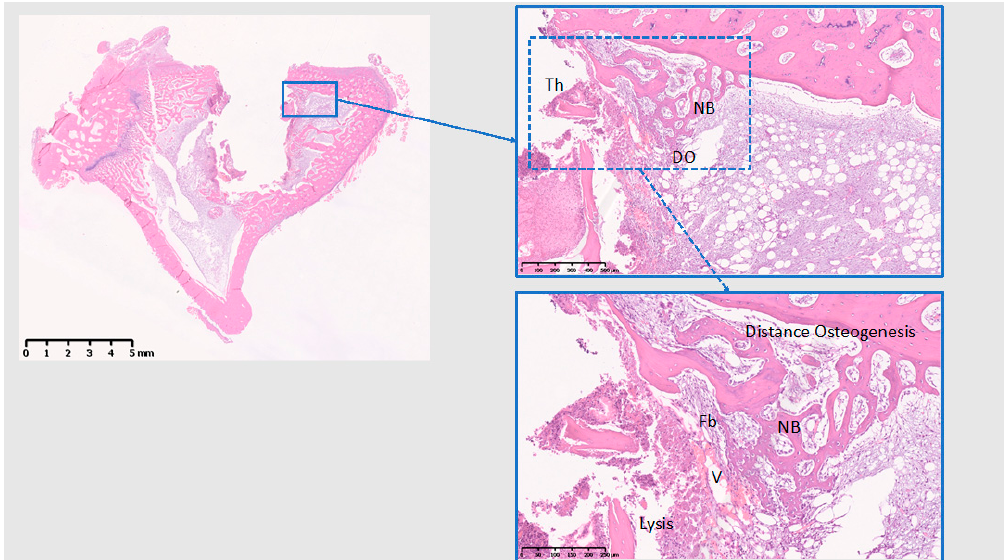
Figure 9. Histological analysis of Cu (10 days). Lytic area next to the implant; Fb: fibroproliferative; NB: New bone; DO: distance osteogenesis; Th: implant thread; V: blood vessel. New bone forming away from the implant surface. Scale bars: 5 mm, 500 µm, and 250 µm clockwise from left.